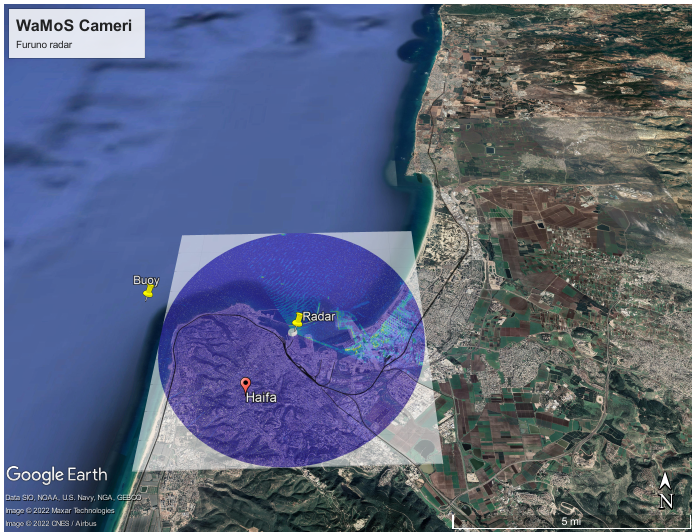
Figure 1. Google map showing the position of the WaMoSII radar system in Haifa port and the associated radar range of 5 km. The overlay radar image shows signatures of ships and breakwater as well as sea clutter. Furthermore the location of the reference buoy offshore is marked with a yellow pin near the southern cape of the